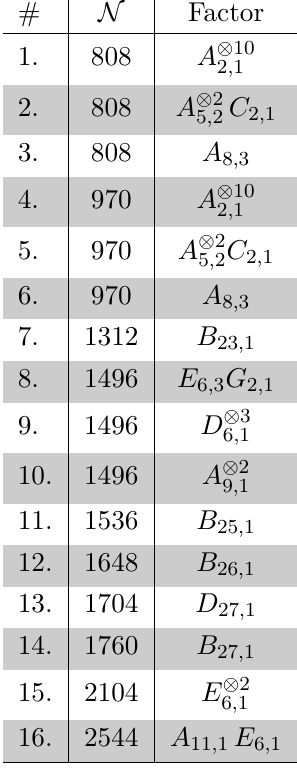
Table 22. List of meromorphic theories ruled out by table 21.